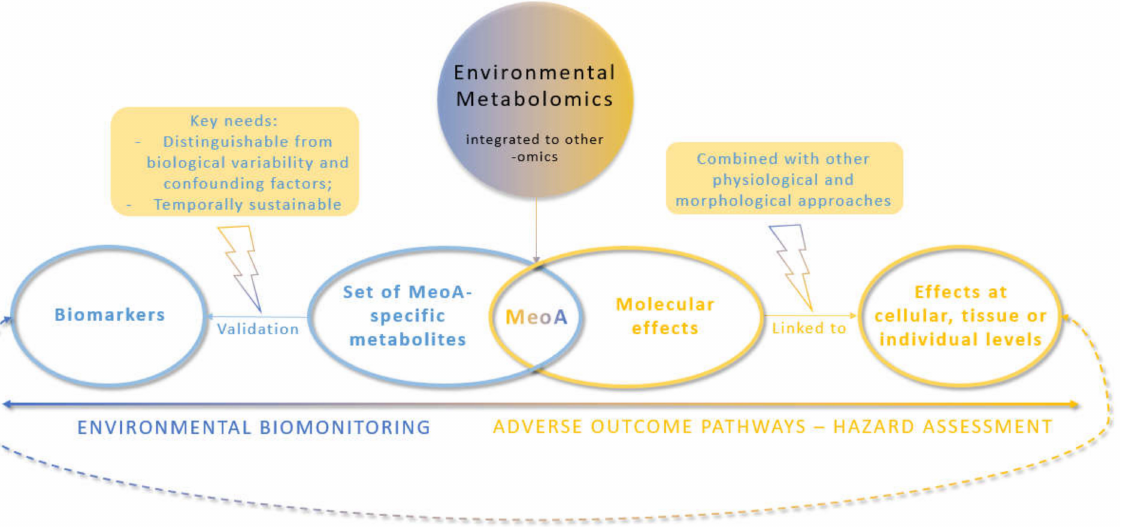
Figure 2. Environmental metabolomics strategy to generate meaningful and useful knowledge for hazard assessment and